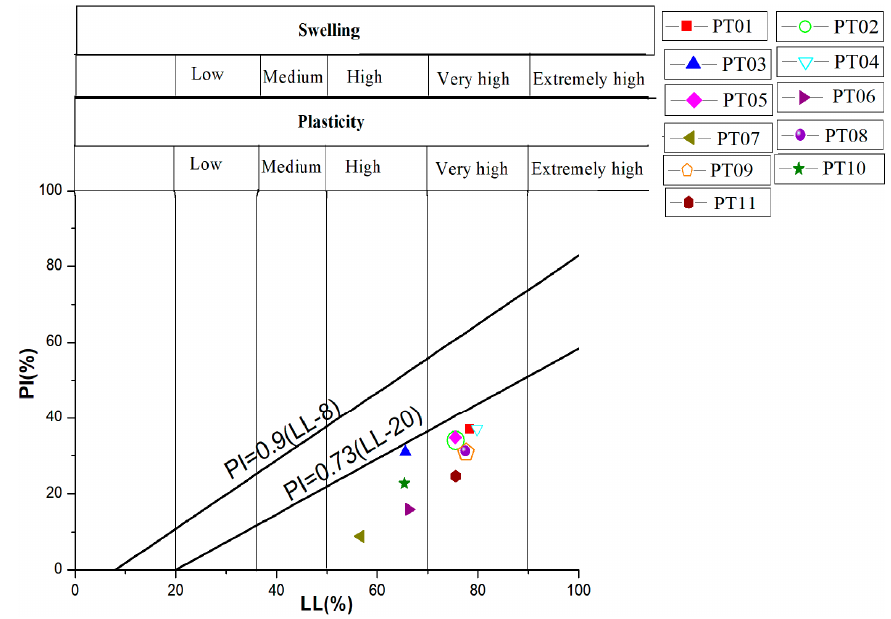
Figure 7. Casagrande’s diagram showing plasticity and swelling capacity. The samples show high to very high plasticity and swelling potential (modified from [47]).